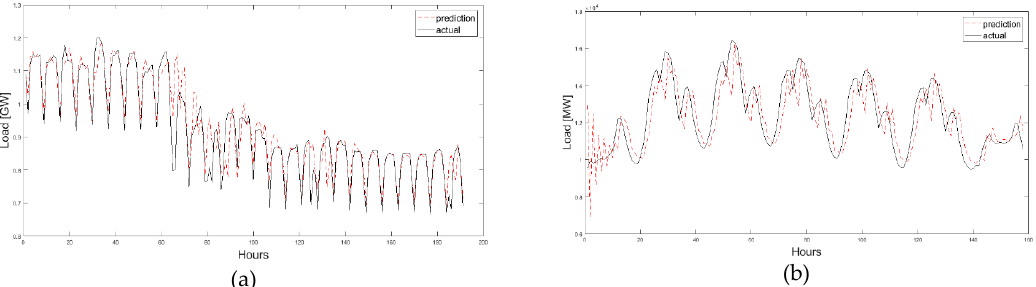
Figure 10. Visualization of predictions (dashed) over actual (continuous) values for the ( a ) Polish and ( b ) Brazilian test sets.